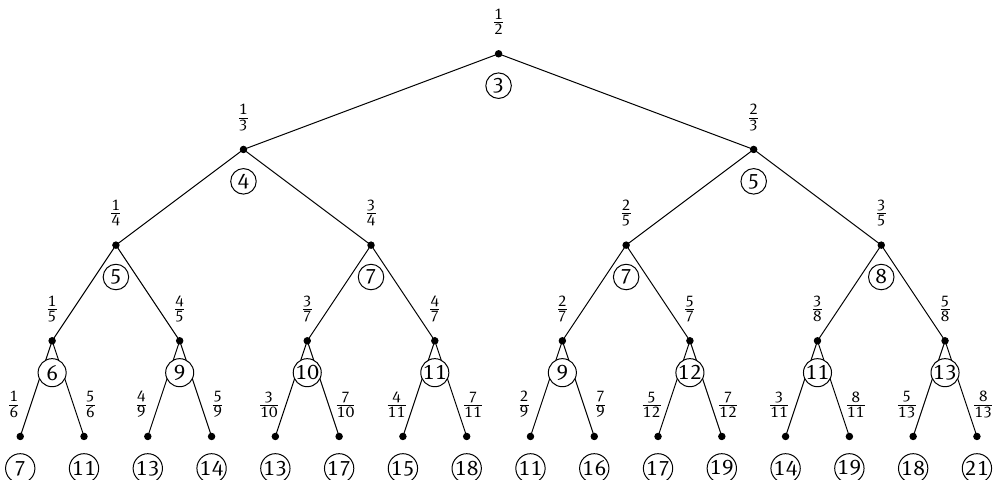
Figure 4: Part of Kepler’s Tree of Fractions and absolute determinants of the matrices H λ .